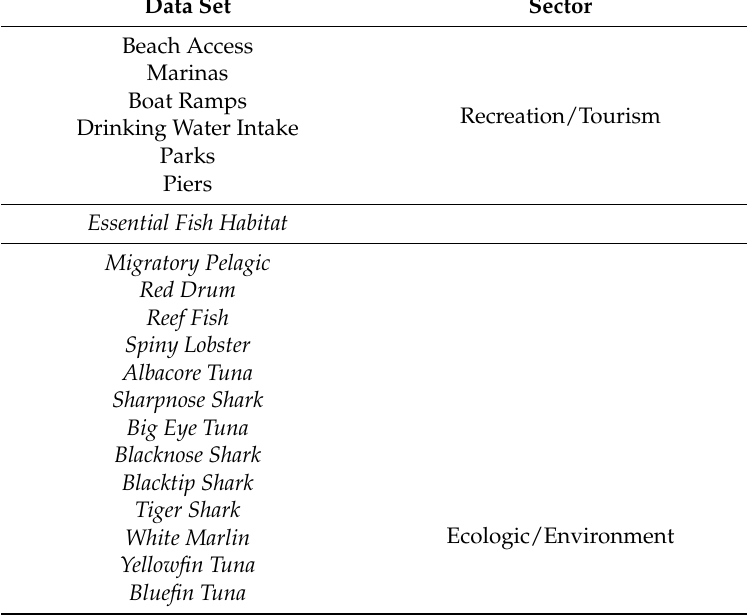
Table A1. Data sets used to determine the vulnerability of each of the grid cells in the analysis. Data was marked as present or absent within a grid cell and summed to determine the vulnerability of the grid